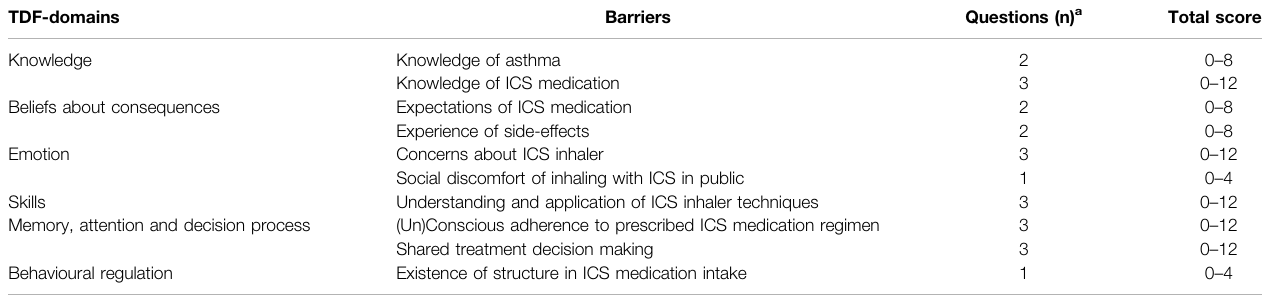
TABLE 1 | RACE questionnaire construct for the identi fi cation of self-management barriers.